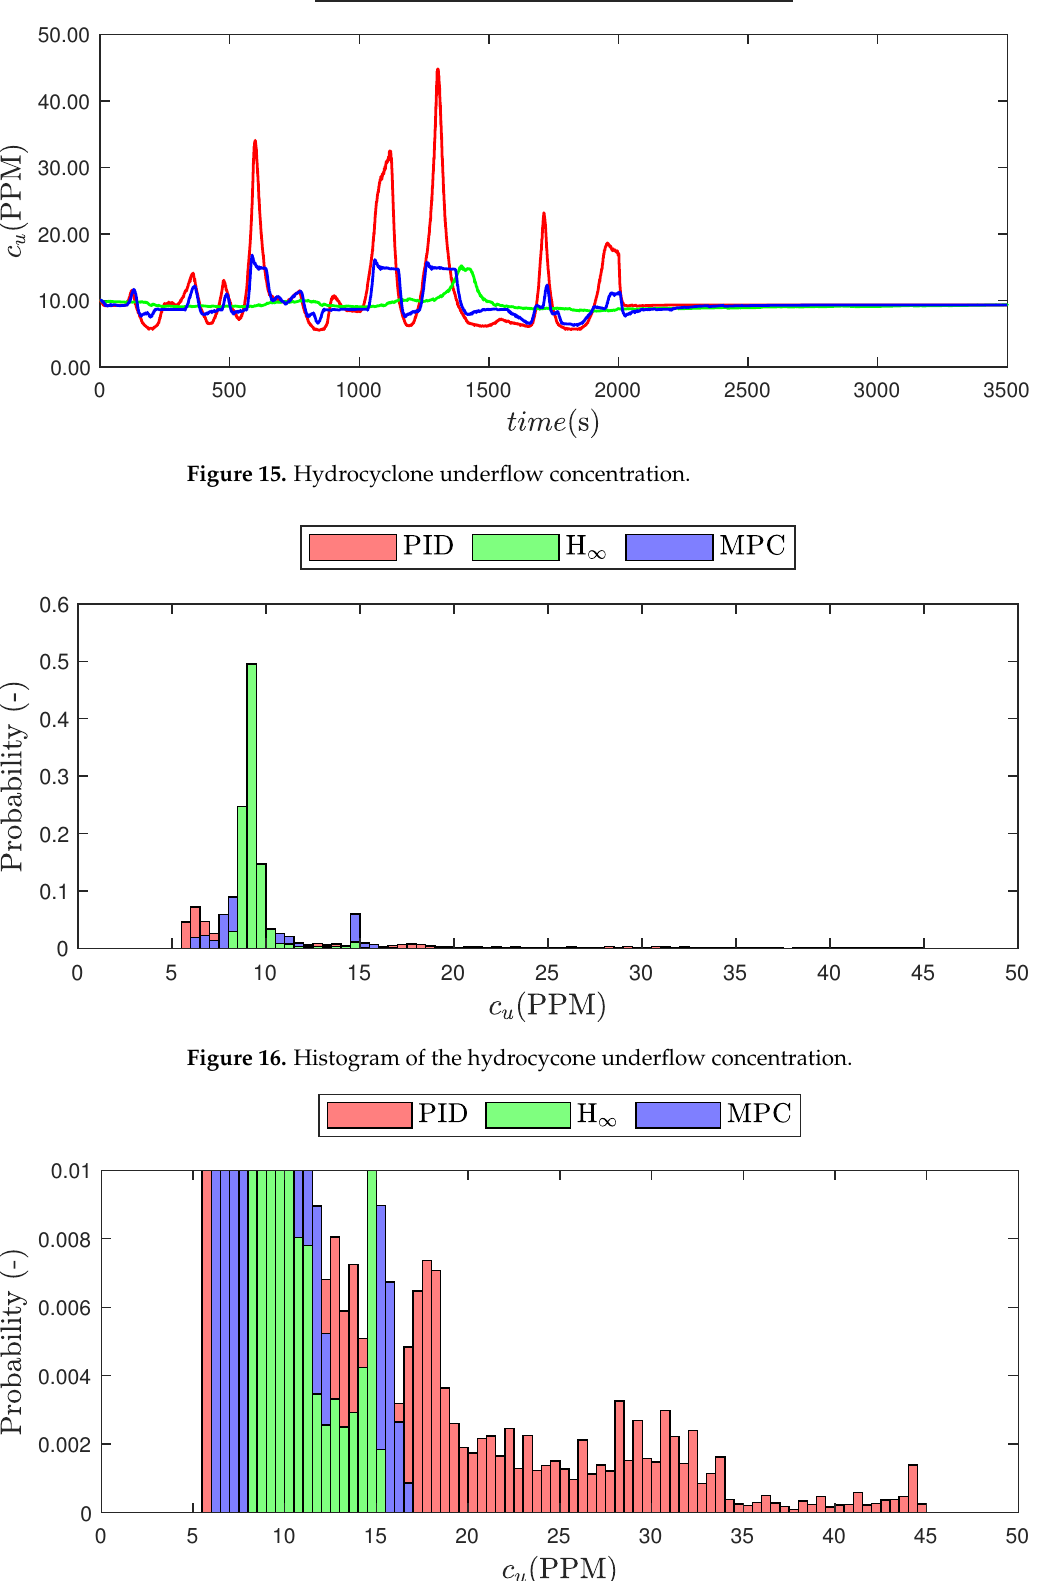
Figure 17. Histogram (zoom) of the hydrocyclone underflow